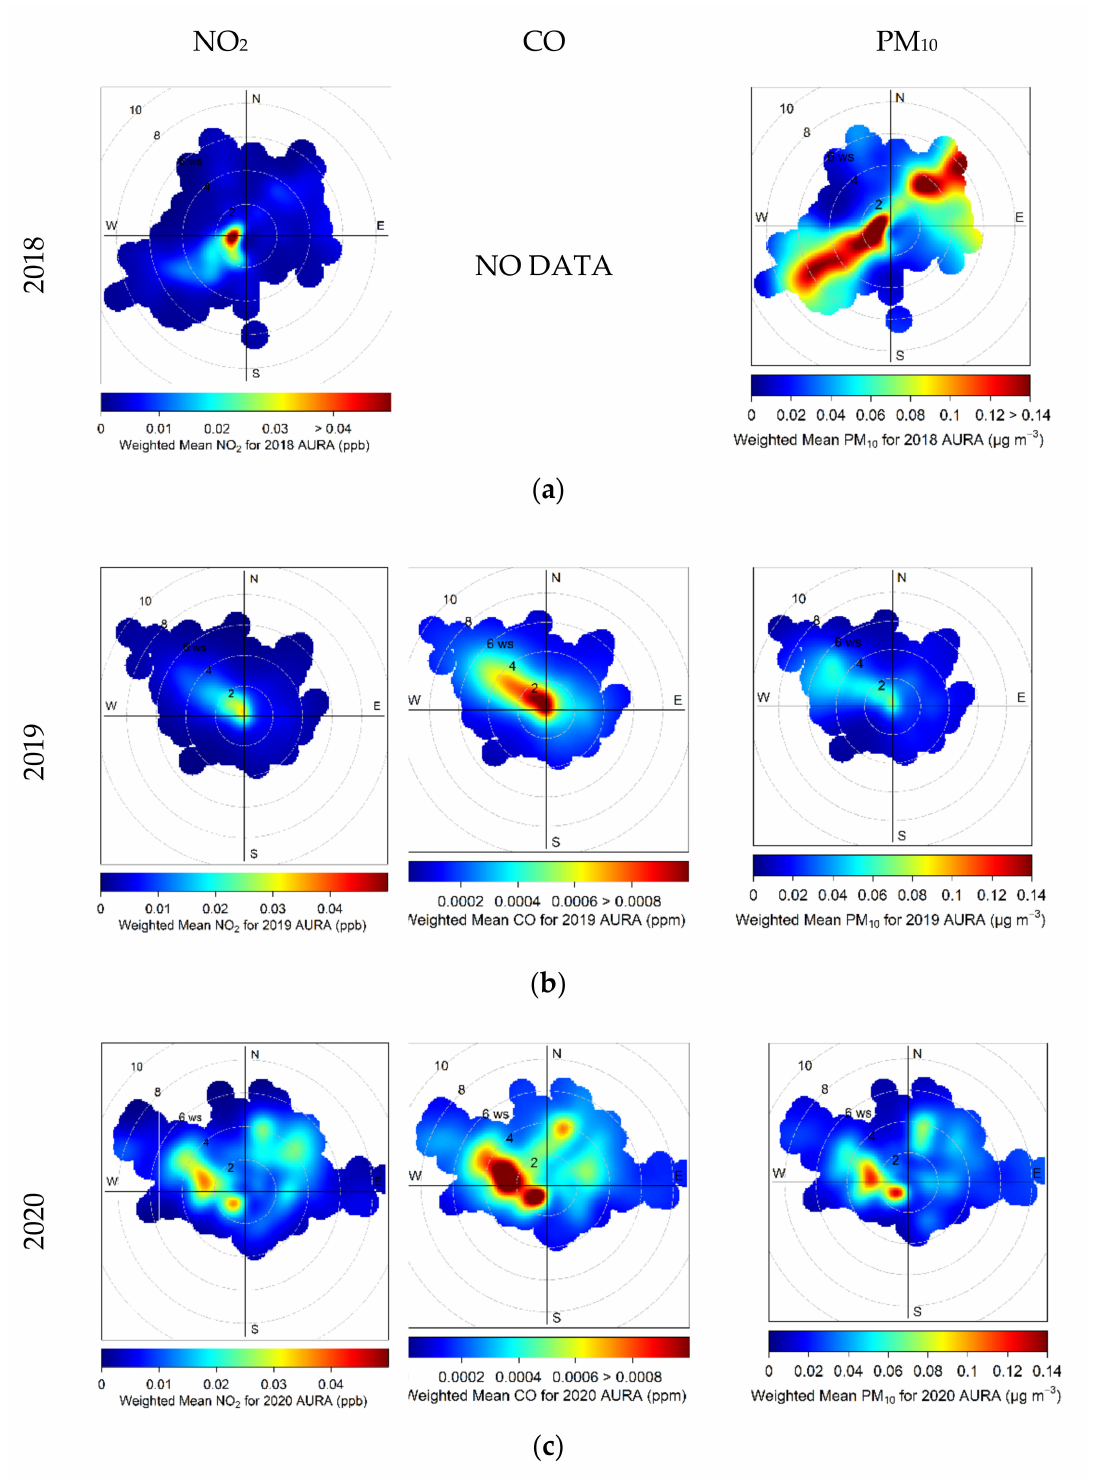
Figure 13. Respective weighted bivariate polar plots for the three main pollutants NO 2 (left column), CO (centre column) and PM 10 (right column) at the AURA station, during ( a ) 2018, ( b ) 2019 and ( c ) 2020 for the lockdown